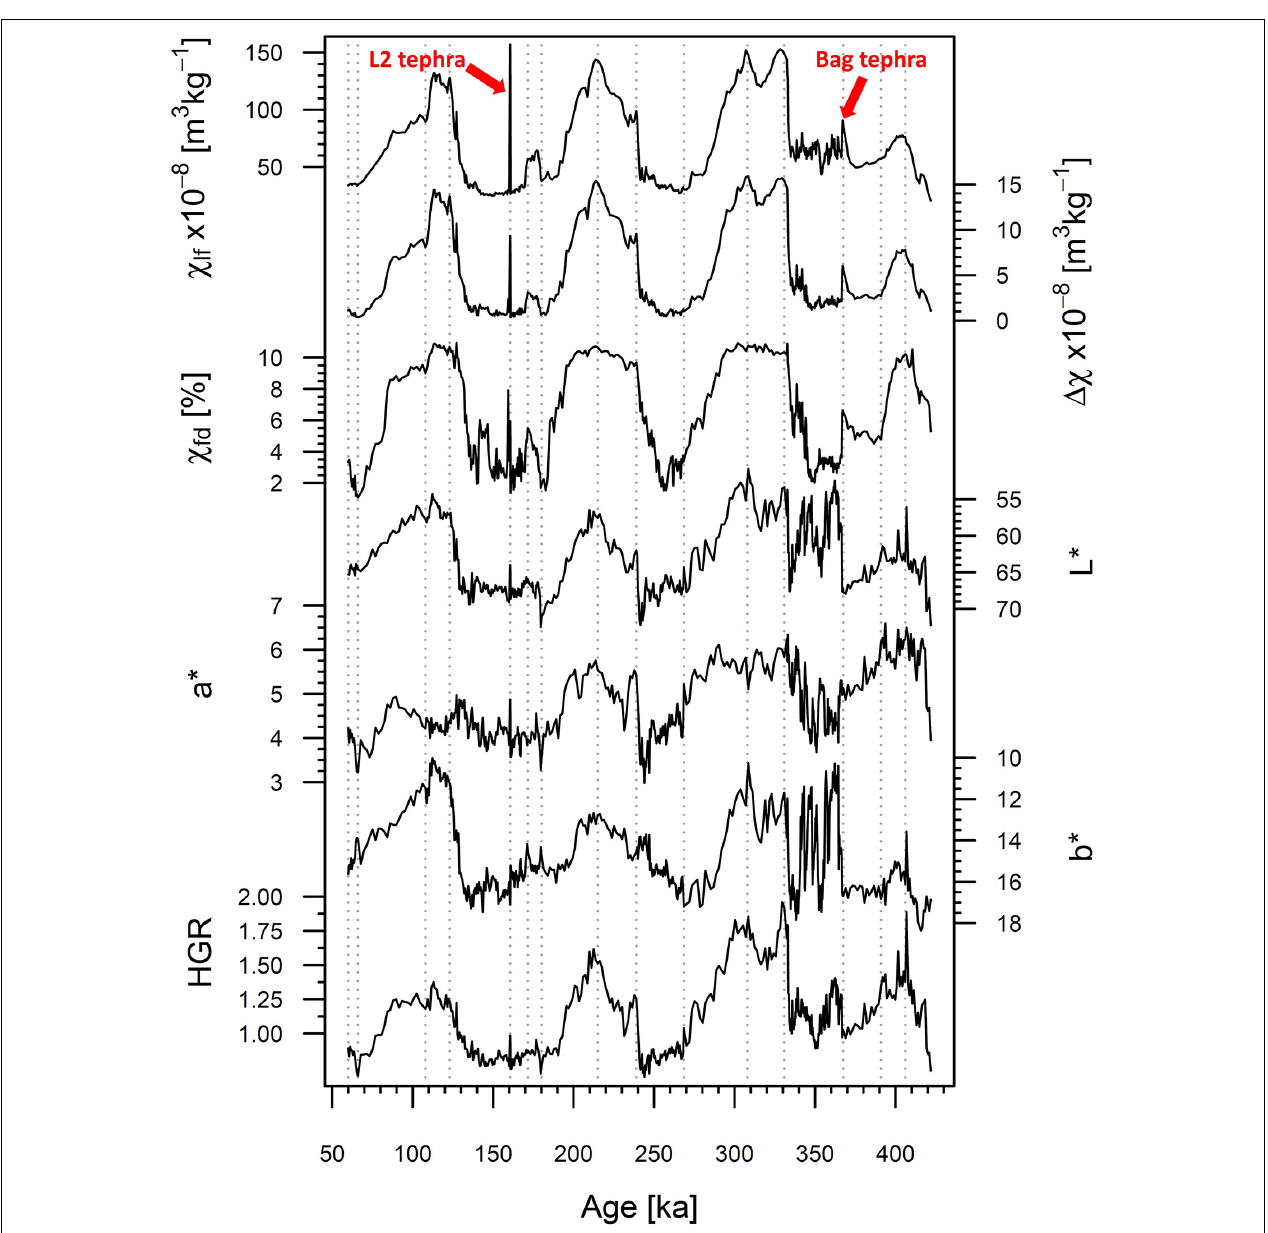
FIGURE 10 | Magnetic susceptibility parameters χ lf , (cid:49) χ , χ fd [%], and the hematite/goethite ratio (HGR) as function of age. Note that the axes for L* and b* are inverted. The gray dotted lines indicate the tie-point-ages from Table 1 .